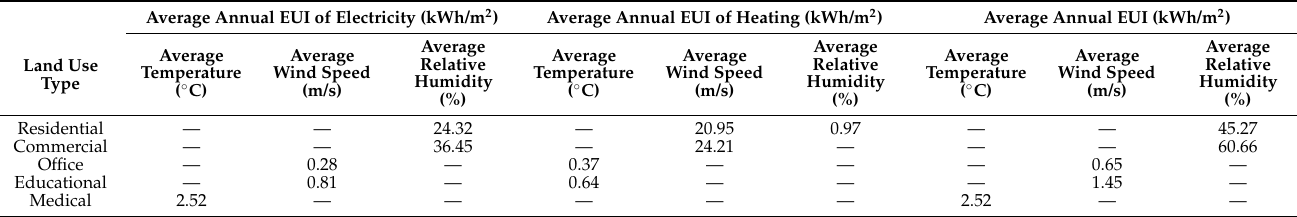
Table 14. Simulation EUI of climate